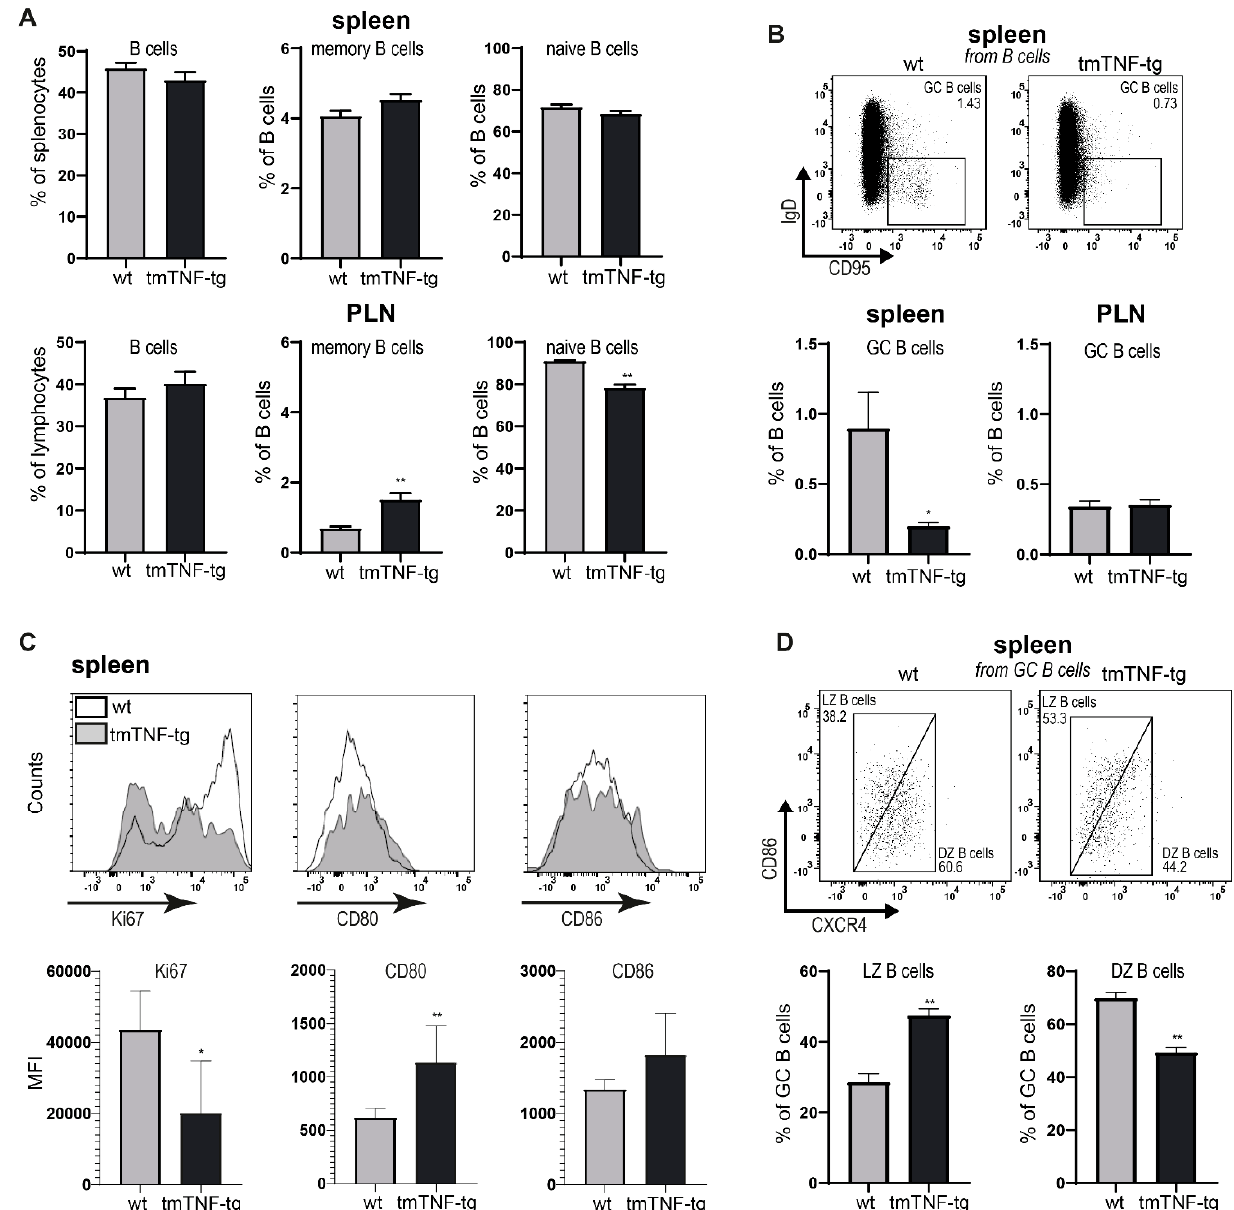
Figure 2. Reduced GC B cell formation in the spleen of tmTNF-tg mice. Different B cell populations were analyzed by flow cytometry. ( A ) Spleen and PLNs of tmTNF-tg mice have normal total B cell proportions (left panels), an increase in memory B cells (middle panels) and a decrease in naïve B cells (right panels). ( B ) Representative dot plots showing the gating strategy to separate CD95 + IgD − GC B cells (from B220 + CD19 + populations). The spleen of tmTNF-tg mice had decreased